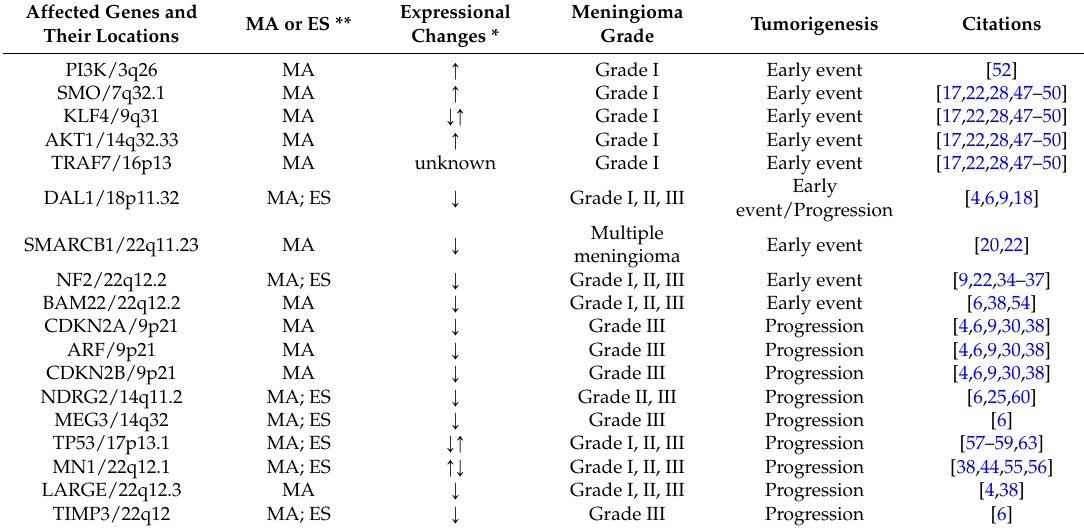
Table 1. Genetic and expression alterations reported in